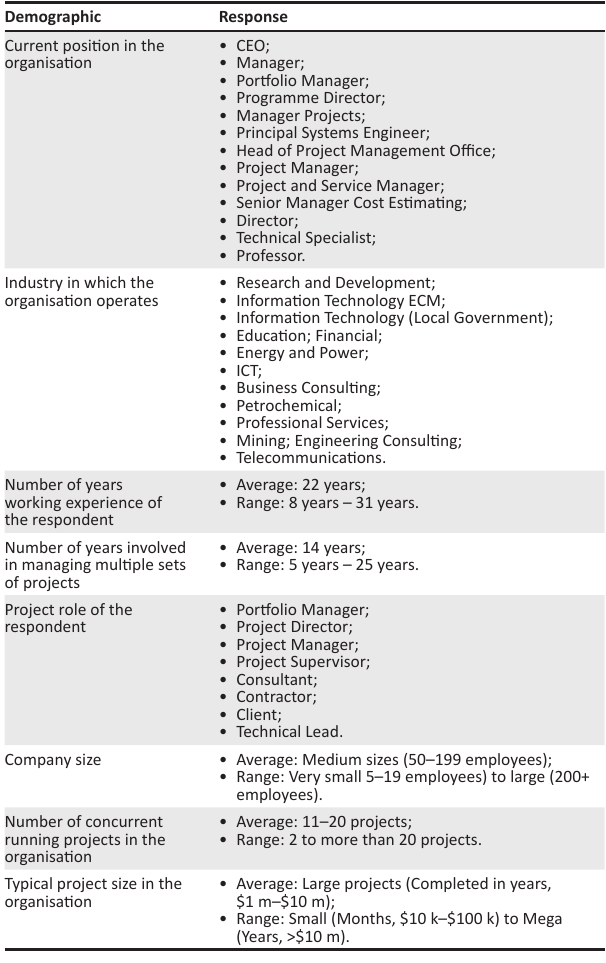
TABLE 7: Expert group